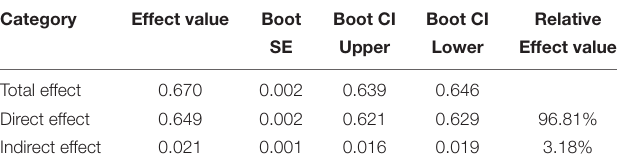
TABLE 5 | Breakdown of total effect, direct effect, and mediating effect.